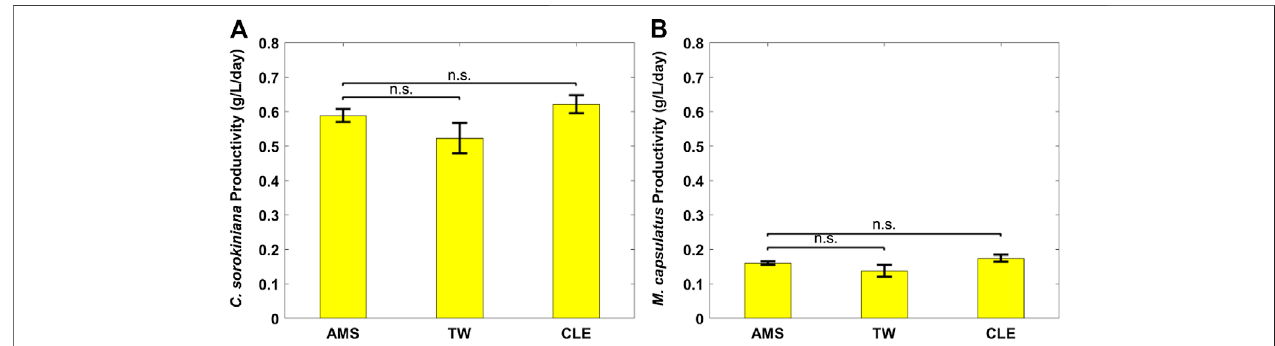
FIGURE 3 | Biomass productivity of individual coculture strains on different anaerobic digestion diluents: (A) Chlorella sorokiniana and (B) Methylococcus capsulatus .TheDunnett ’ stest,withammoniummineralsalts(AMS)asthecontrol,indicatesthatthesedifferencesarenotsigni fi cant(n.s.)statisticallyatsigni fi cancelevel α (cid:2)